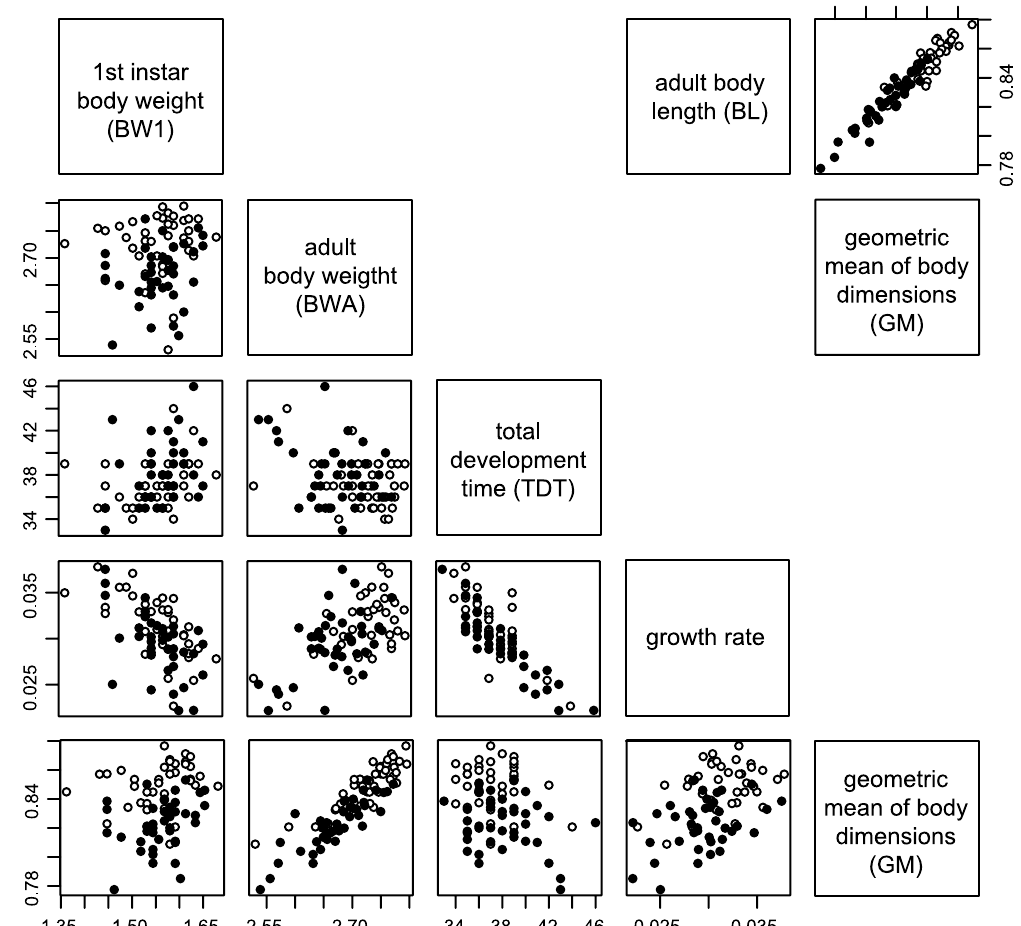
Figure 2. Correlations between developmental trait values and body size dimensions. Open and closed circles indicate male and female individuals, respectively. BW1, BWA and BL are log 10 transformed values, and GM (geometric mean of all body dimensions) was calculated as the arithmetic mean of all log 10 transformed body dimensions except